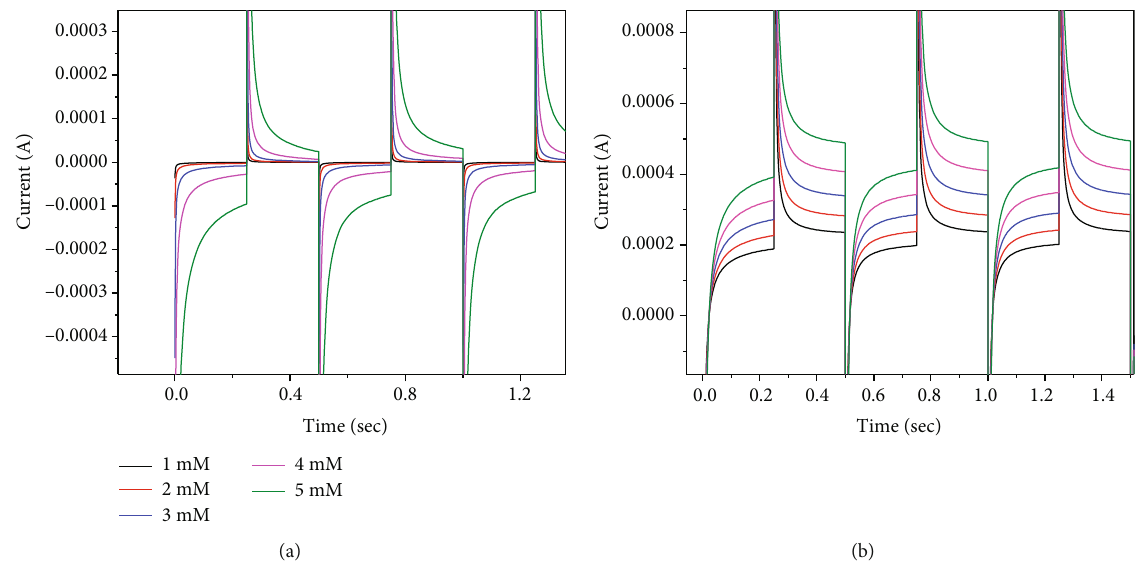
Figure 14: Amperometric i – t curve for determination of mercury and lead using ZrO